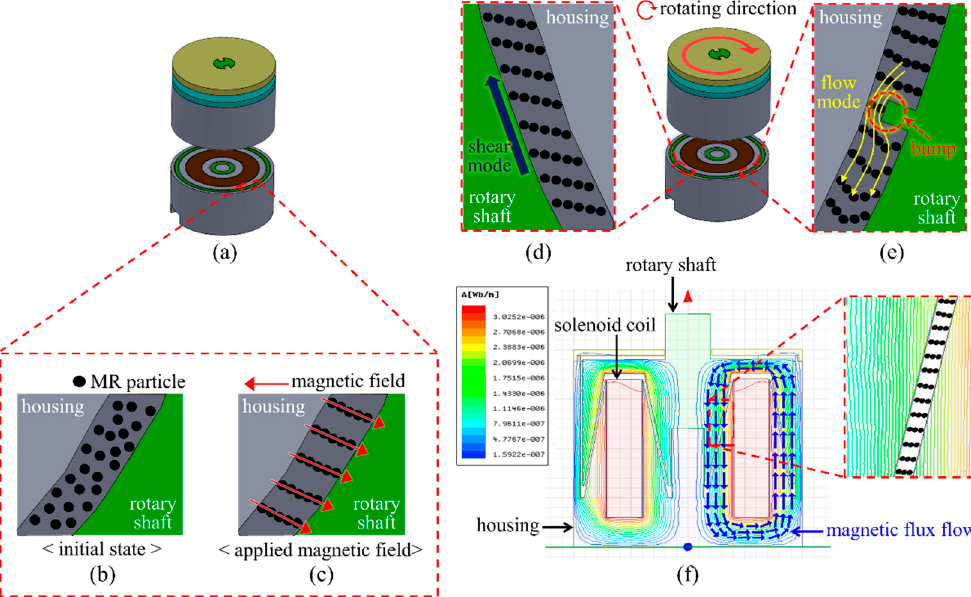
Figure 5. Operating principle of the proposed haptic knob and its finite element method simulation: ( a ) Design of the proposed haptic knob; ( b ) magnetorheological (MR) fluids before magnetic field; ( c ) MR fluids after magnetic field; ( d ) shear mode of MR fluids; ( e ) flow mode of MR fluids; ( f ) finite element method simulation of the proposed haptic knob.